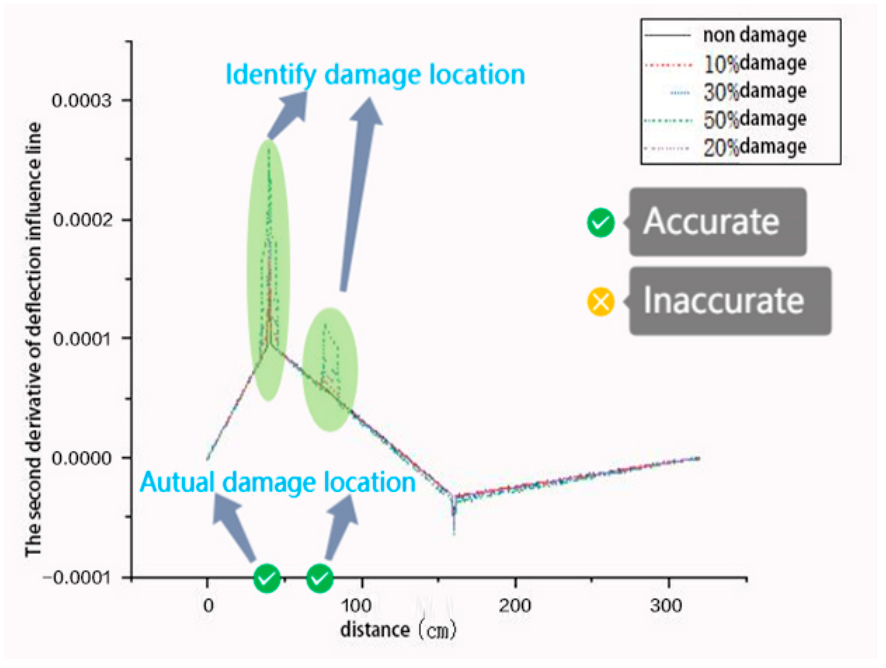
Figure 14. The 2nd derivative of deflection influence line at 1/4 determining point of the 1st span following work condition 2 (2-5).